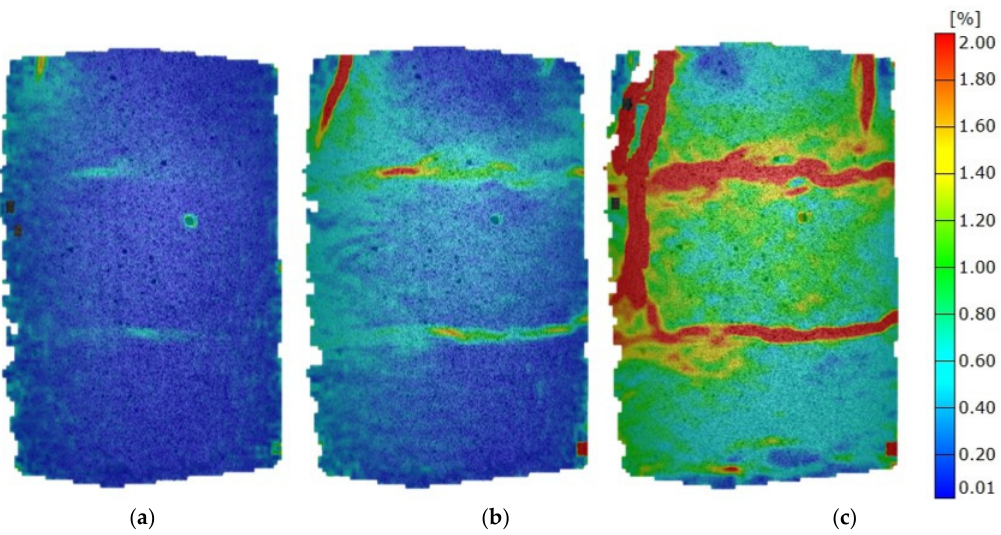
Figure 8. Mises strain at various load stages of mixtures with wheat fly ash. ( a ) 0.3 F max ; ( b ) 0.6 F max ; ( c ) 1.0 F max .